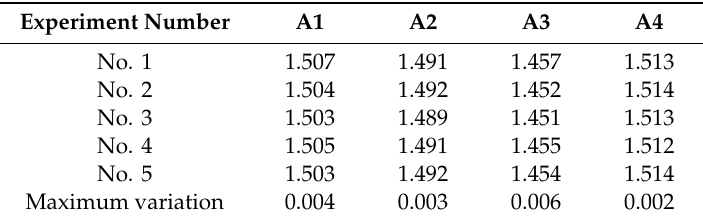
Table 3. The pixel equivalent in di ff erent motion modes ( µ m / pixel).